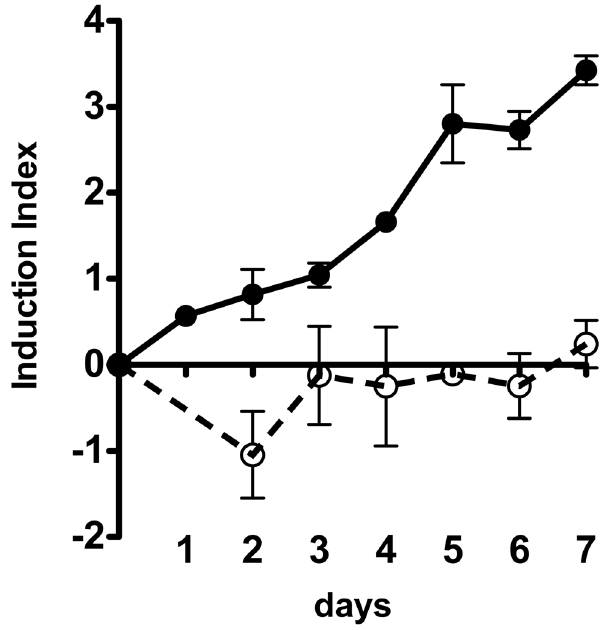
Figure 7. Measurement of in vivo prophage induction. Germ- free mice were infected with 10 6 bacteria. At the indicated times feces were collected, suspended in diluent, and dilutions plated on LB plates, with kanamycin (30 m g/ml), or chloramphenicol (9–10 m g/ml). Graphs N show ratios of CamR/KanR on a log scale (calculated using the Induction ) SIVET strain Index formula) over the indicated number of days. ( K11604. ( # ) K11604 derivatives with 933W cIind mutation; K11607 (locked in KanR) and K11608 (CamR) were co-inoculated. Error bars represent standard error of the mean.